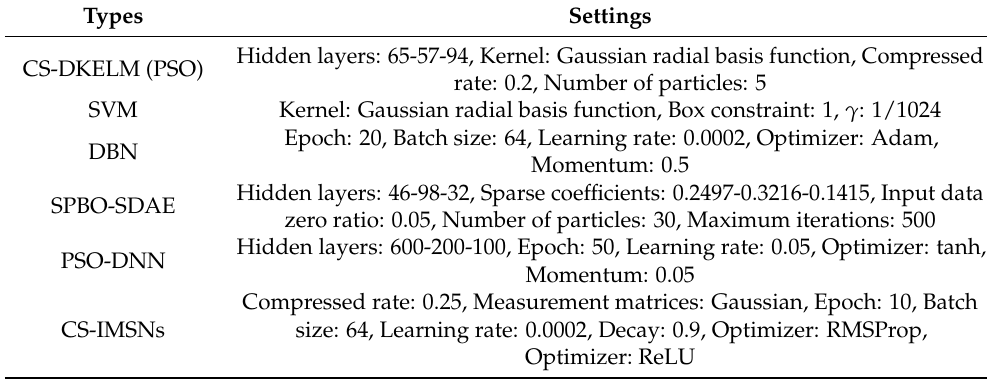
Table 5. Parameter settings for different fault diagnosis methods.